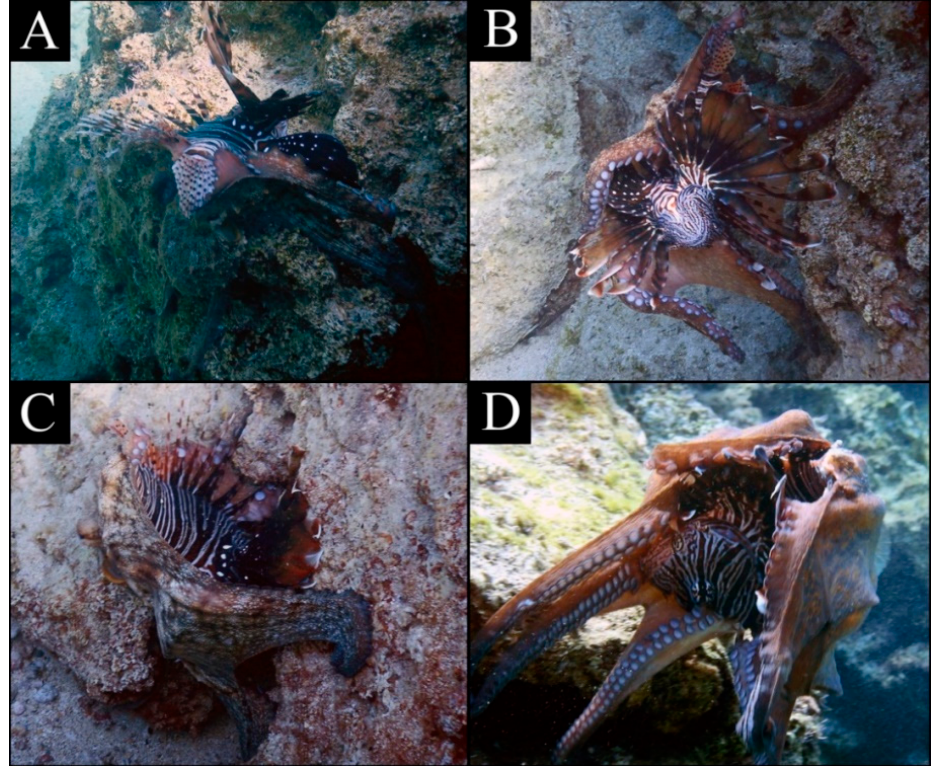
Figure 1. Octopus vulgaris Cuvier, 1797 preying on a lionfish in Famagusta (Cyprus). ( A ) The octopus soon after the catch. ( B ) The octopus enveloping the lionfish with all the arms and the web, moving to the bottom of the cliff. ( C ) The octopus hiding in a small crevice. ( D ) The octopus while moving to a bigger crevice. Photos by Maria Shokouros-Oskarsson.